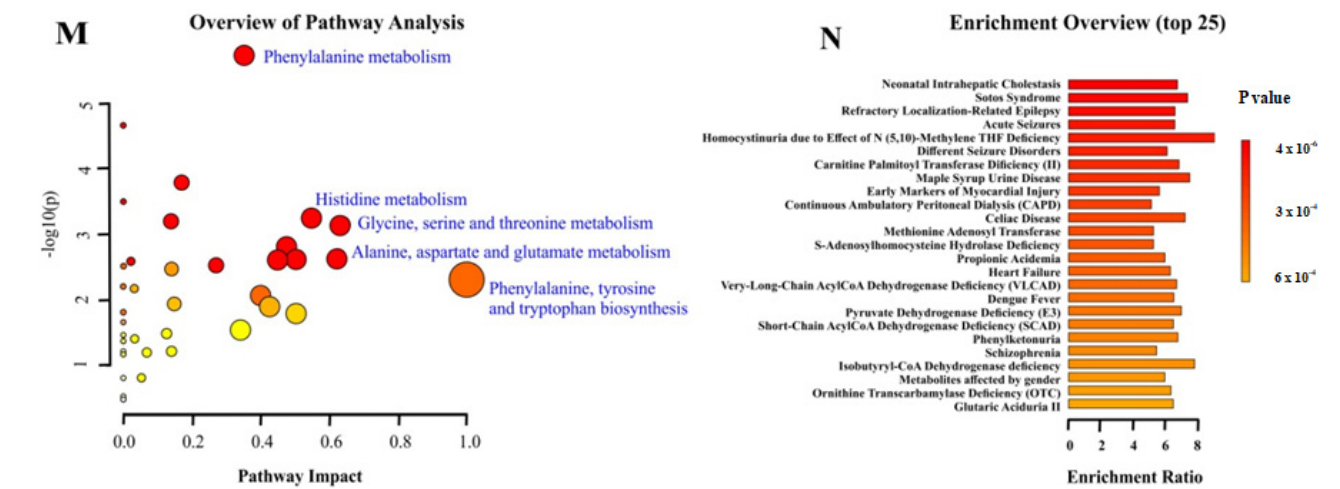
Figure 2. Metabolomic analysis revealed decreased amino acids and effects on related metabolite pathways in Sig1R KO mice. ( A ) Heatmap analysis highlighting metabolites showing the signifi- cant changes in plasma between adult WT and Sig1R KO mice. ( B ) Heatmap analysis highlighting me-tabolites showing the significant changes in plasma between old WT and Sig1R KO mice. ( C , D ) Volcano plot showing statistical significance ( p value < 0.05) versus the magnitude of change (over 1.2) in plasma. ( E , F ) Score plots of PCA-discriminated metabolites in plasma between the WT and Sig1R KO groups. ( G ) Heatmap analysis highlighting metabolites showing the significant changes in brain tissue between adult WT and Sig1R KO mice. ( H ) Heatmap analysis highlighting metabolites showing the significant changes in brain tissue between old WT and Sig1R KO mice. ( I , J ) Volcano plot showing statistical significance ( p value < 0.05) versus the magnitude of change (over 1.2) in brain tissue. ( K , L ) Score plots of PCA-discriminated metabolites in brain tissue between the WT and Sig1R KO groups. ( M ) The metabolome view shows all matched pathways ac- cording to the p values from the pathway enrichment analysis and pathway impact values from the pathway topology analysis. ( N ) Summary plot for quantitative enrichment analysis (QEA). Plasma and brain tissue samples were collected from 6- and 18-month-old WT and Sig1R KO mice ( n = 6–7 mice/group). Analyses were produced using MetaboAnalyst 5.0. Sig.—significantly, Un- sig.—unsignificantly.